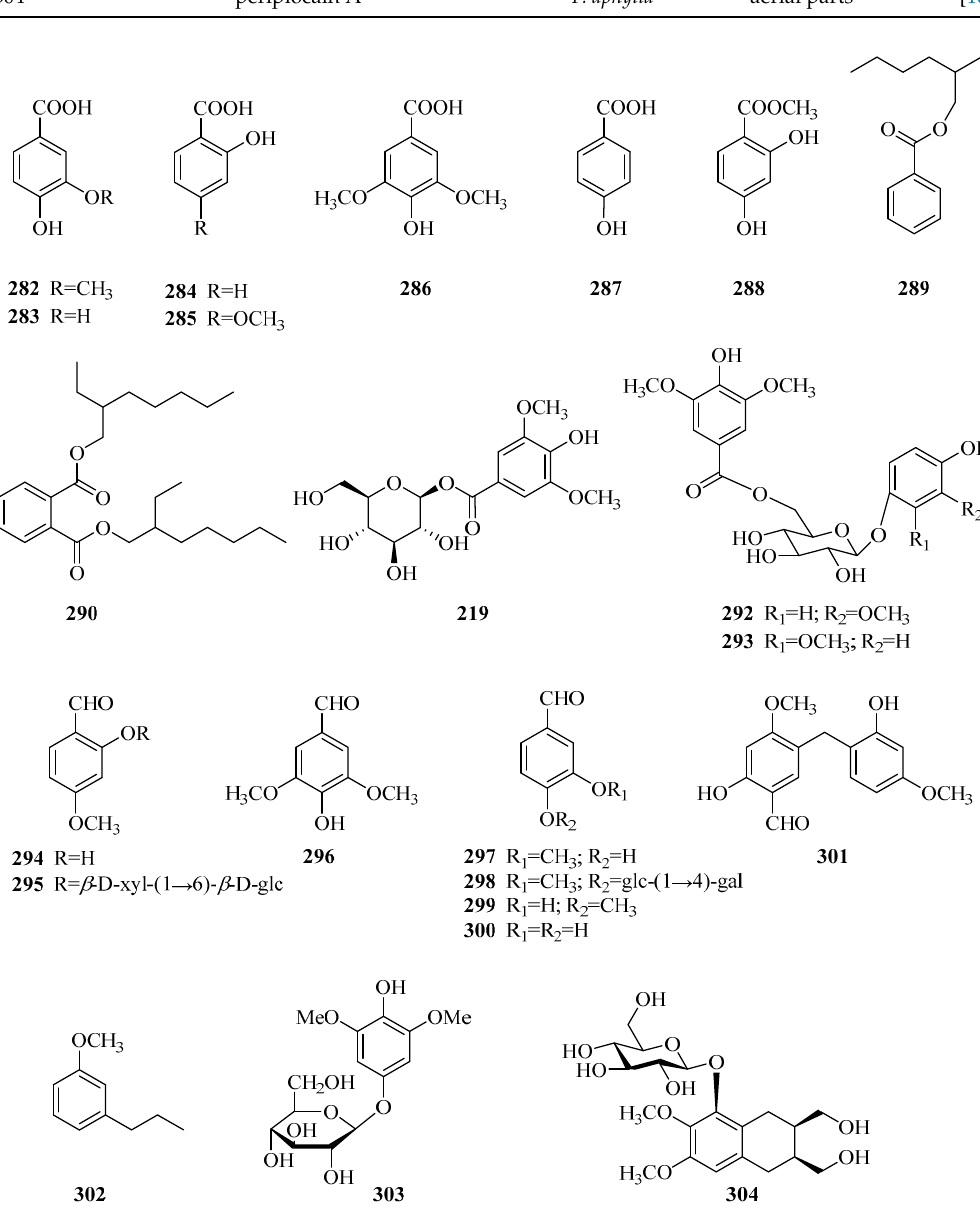
Figure 10. Aromatics from the genus Periploca .